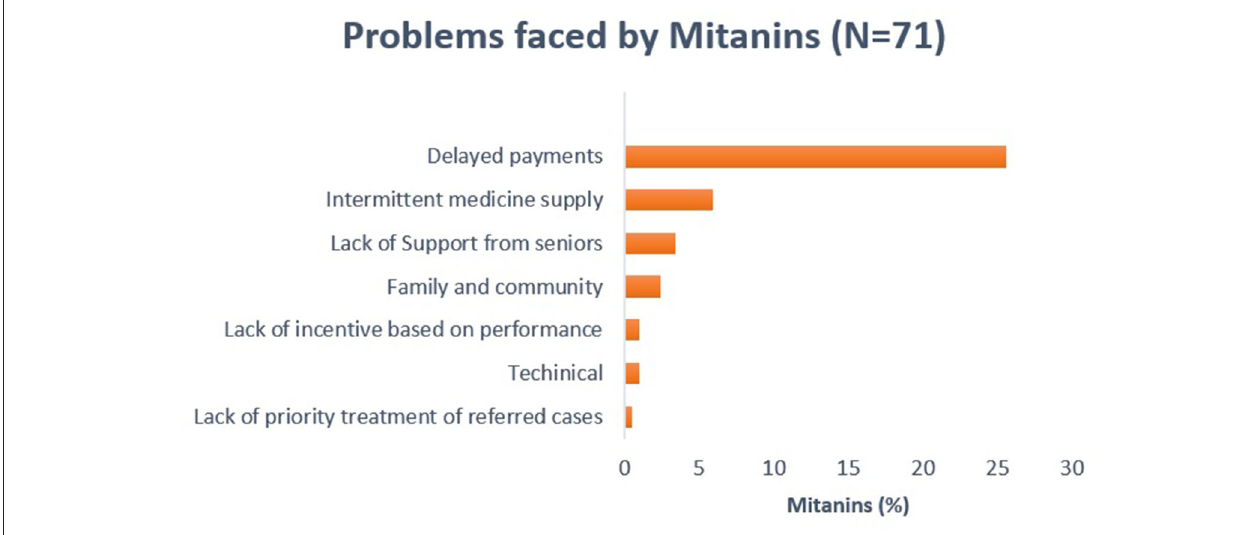
FIGURE 3 | Problems faced by mitanins. Delayed payments and intermittent medicine supply are major problems faced by mitanins.